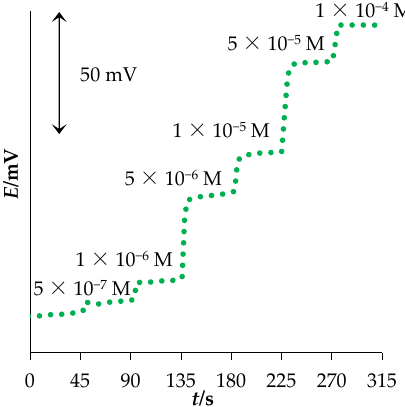
Figure 3. Dynamic response of the new MWCNT-OSO 3 − TBZ + sensor.